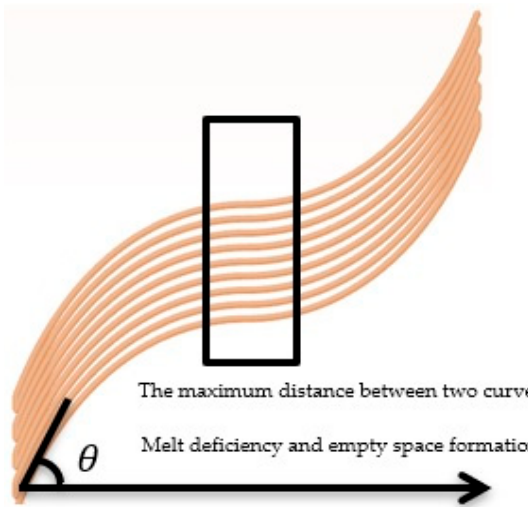
Figure 4. Curved paths with a start and end angle of 70° and a center angle of 0°.